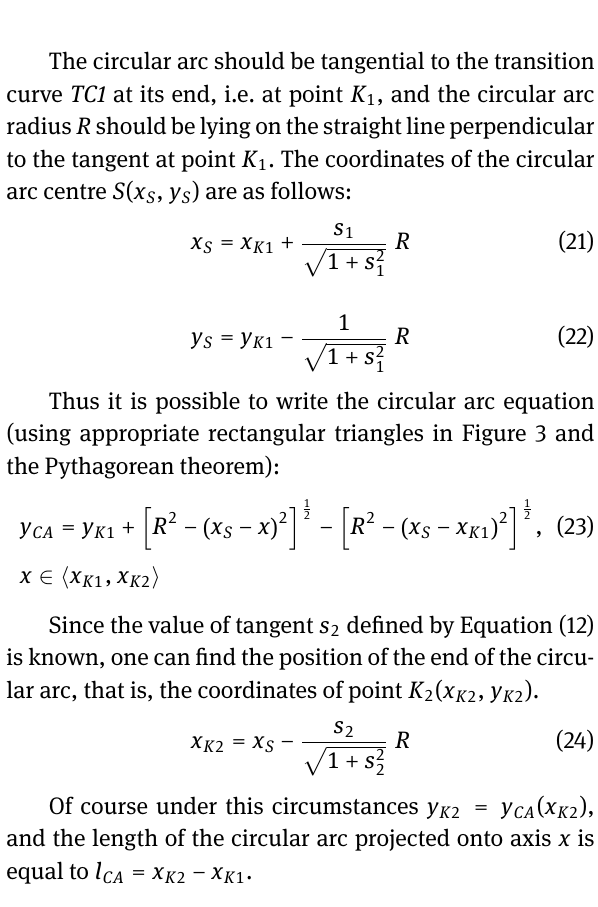
Figure 3: The designed geometric lay-out applied to the local coordi- nates system